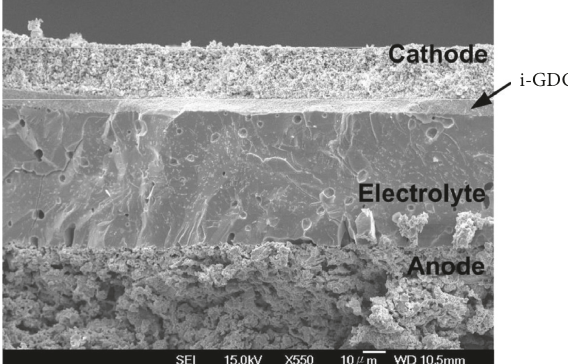
Figure 4: The cross-sectional image shows the interface structure of the